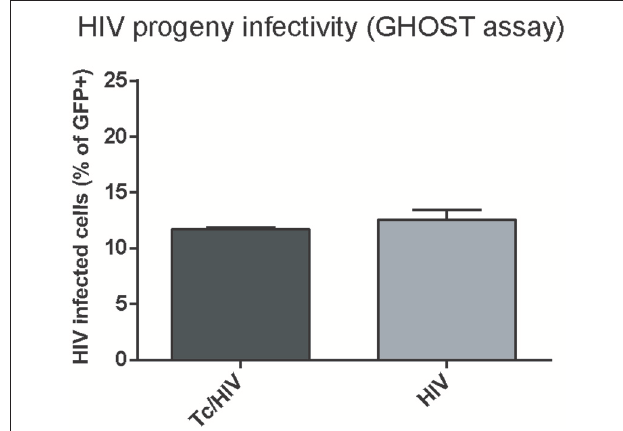
FIGURE 6 | Trypanosoma cruzi effects on infectivity of the HIV progeny. GFP expression in GHOST cell culture inoculated with supernatant from HIV and Tc/HIV was measured by flow cytometry at 3 dpi. Mean values ± SD from three different experiments. No significant differences were found between the two conditions ( >